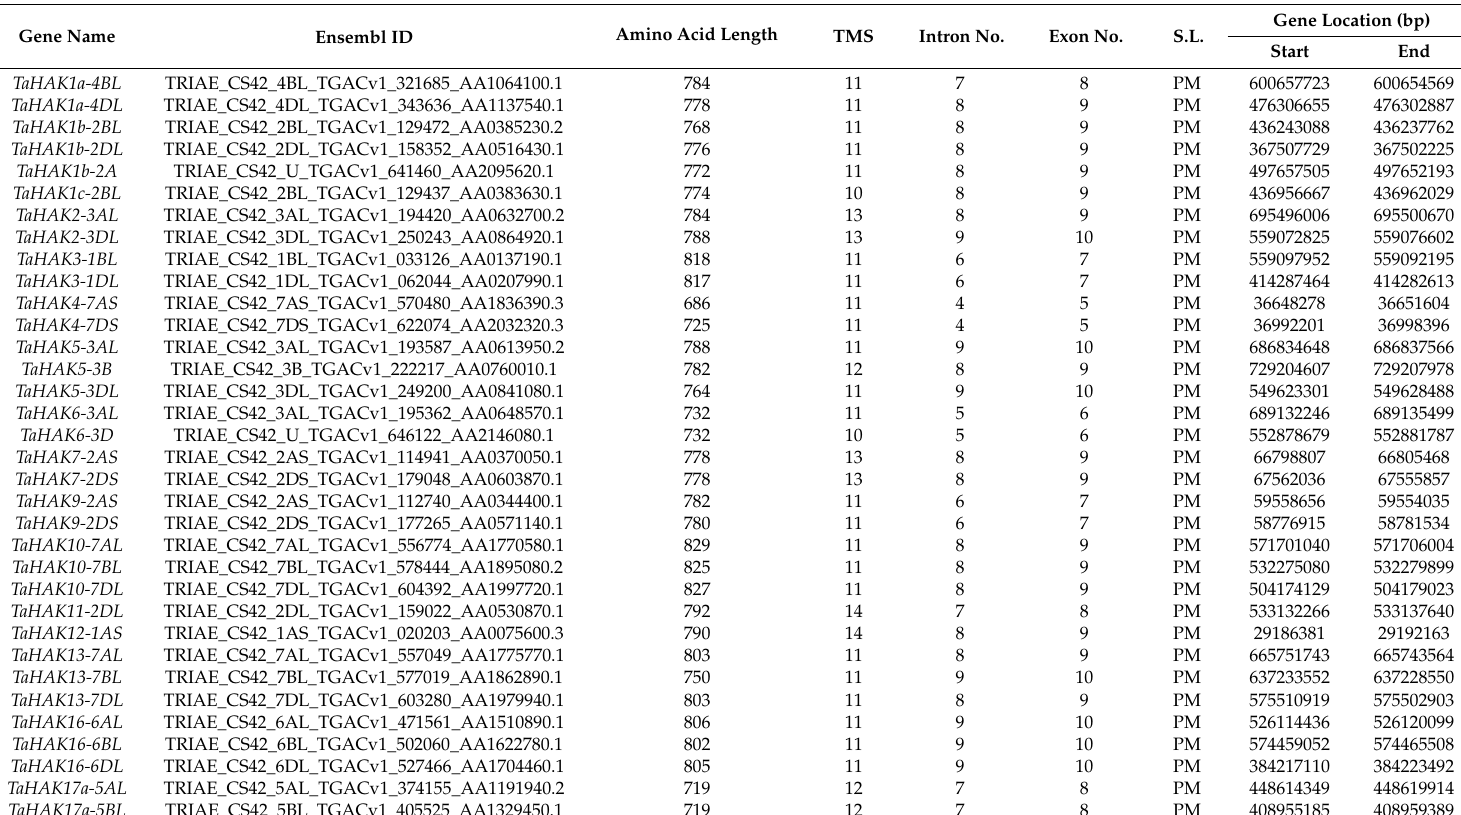
Table 1. TaHAK genes identified in wheat. Twenty-five TaHAK family members are indicated by white or light grey blocks. TMS, transmembrane segments; S.L., subcellular location; PM, plasma